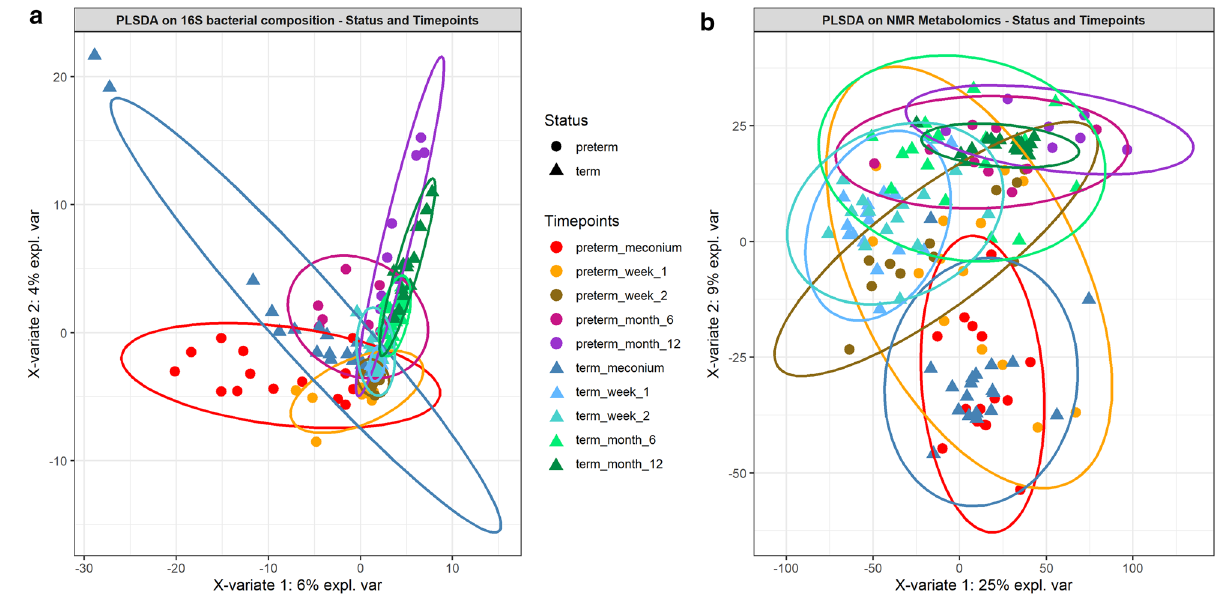
Figure 2. PLS-DA models of ( a ) 16S bacterial composition and ( b ) NMR metabolomics. The models were built on inter-subject vs the five collection time points and colour coded by group with 95% confidence eclipses. Both validated with fivefold cross-validation. PLS-DA plots were generated using R statistical software (version 3.5.0, https ://cran.r-proje ct.org/).